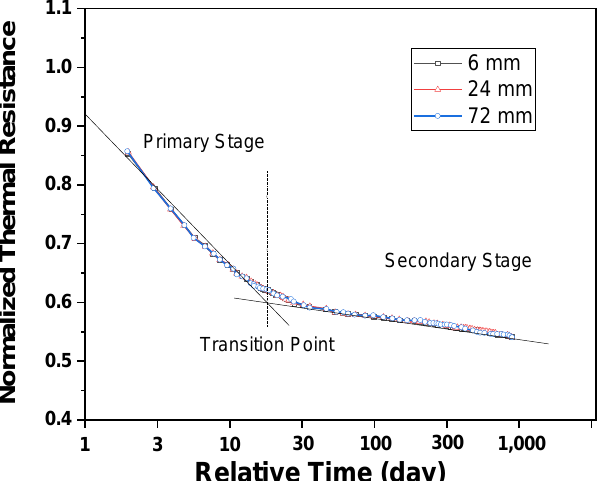
Figure 3. Relative thermal resistance of cellular plastic foams with three different thicknesses after scaling factor was applied. Redrawn by importing the points from image under the permission by ISO member in author‘s country[6].